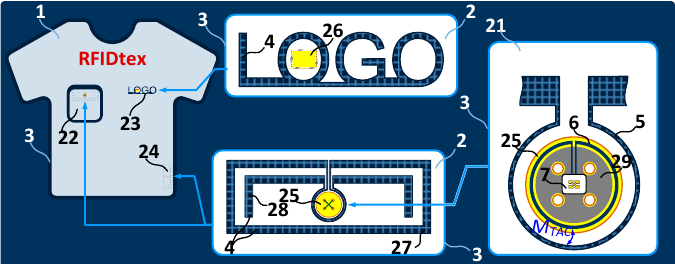
Figure 28. Implementations of textronic product with RFID interface. Implementations of textronic structure: 22—as hidden structure in internal layers of product, 23—in form of company logo, 24—in form of tag. Examples of microelectronic module implementation in the form of: 25—button, 26—emblem, strips/woven or other designs desirable in the textile industry. 21—part of textronic structure; 27—HF antenna; 28—UHF antenna; 29—magnetic, diamagnetic or ferromagnetic material; 1—7 as in Figure 27.